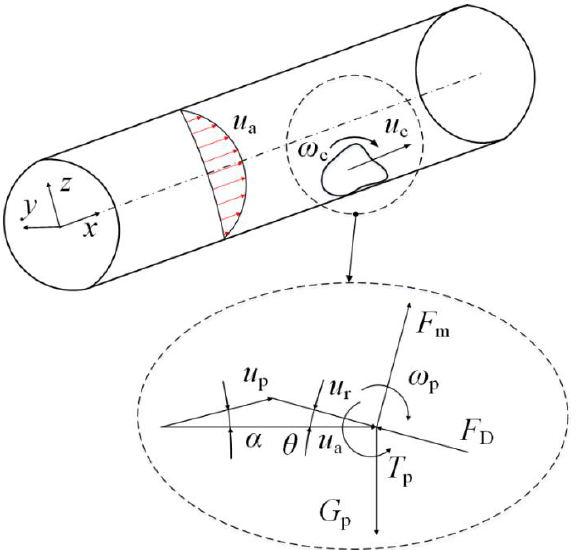
Figure 11. Forces analysis of single spraying particle in horizontal axial pneumatic conveying.